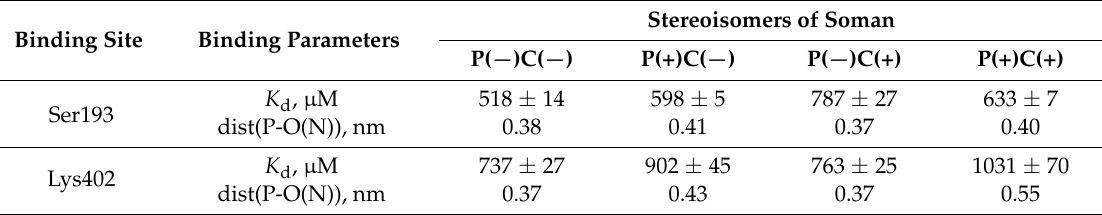
Table 2. The result of the molecular docking of the isomers of soman into the sites Ser193 and Lys402 of